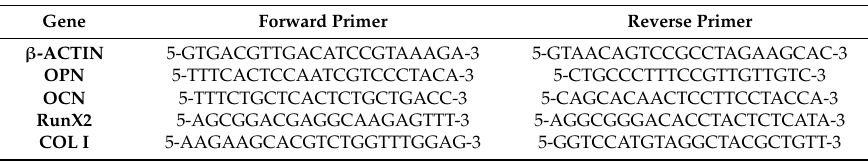
Table 1. Primers sequence used for RT-qPCR.